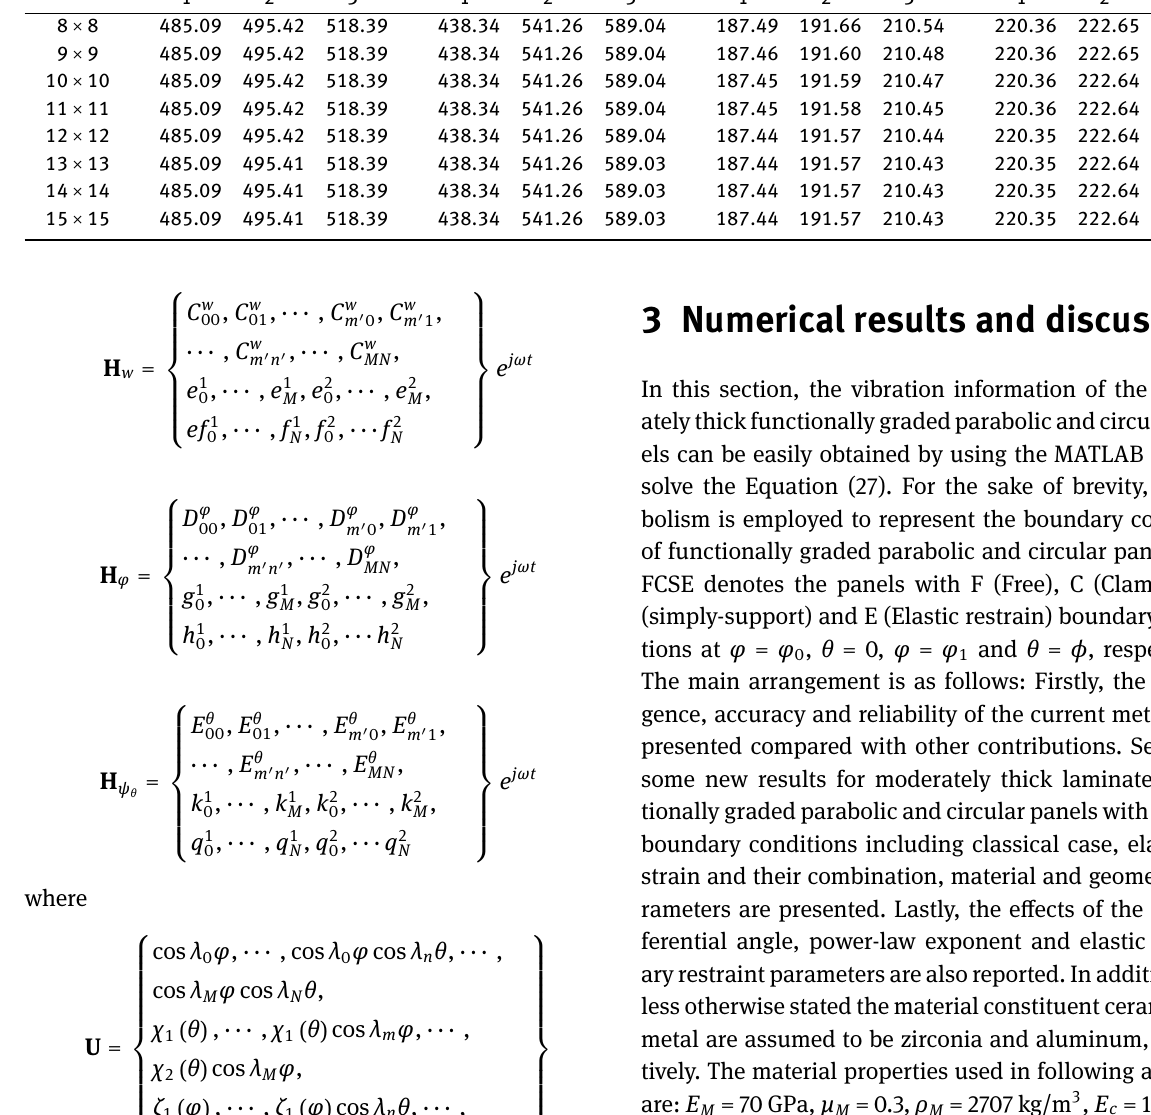
Table 2: Convergence of frequency parameters Ω for functionally graded panels with complete free boundary conditions. Spherical panel Toro-circular panel Toro-parabolic panel Parabolic M × N